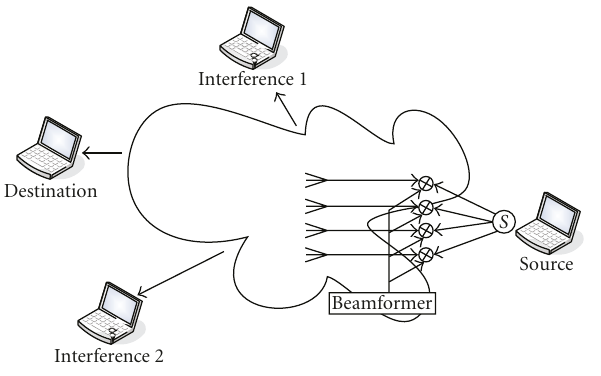
Figure 2: Simple beamforming strategy.